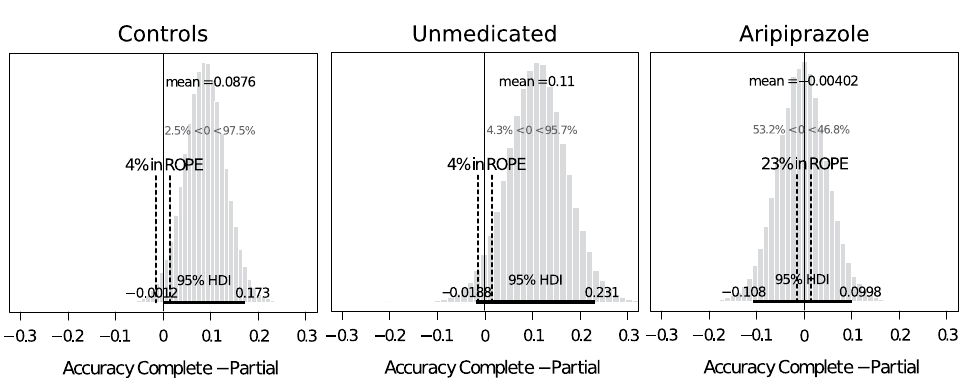
Figure 4. Results of the Bayesian analysis for evidence in favour of the null hypothesis for the difference between accuracy in the complete and partial feedback conditions (i.e., « counterfactual gain ») for each group. ROPE is the region of practical equivalence, which was set at the level of 3% ([ − 1.5%, 1.5%]. “4% in ROPE” means that there is a 4% chance that the true average counterfactual gain lies within the region of the practical equivalence interval.